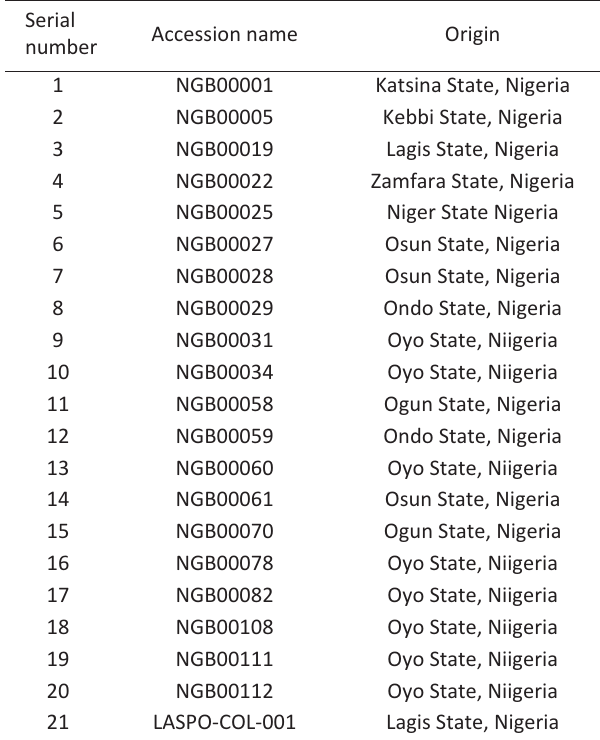
Table 1 ­ Origin of the 21 Amaranthus hybridus accessions